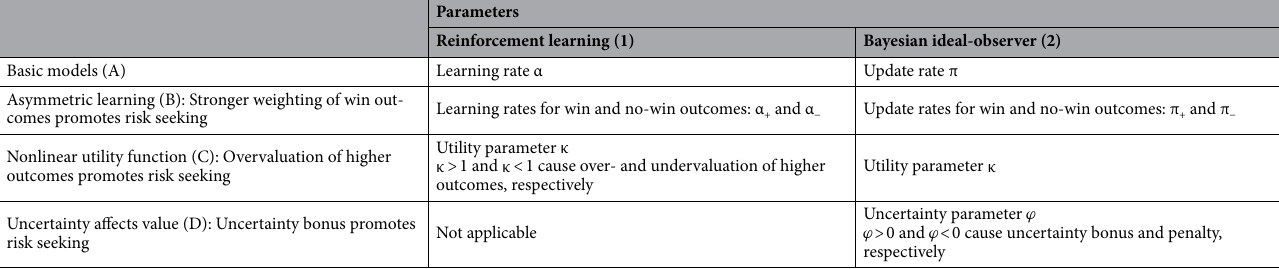
Table 1. Overview of the learning models. The initial value of the risky option ( Q 1 ) was a free parameter in all models as well (not included in the table).